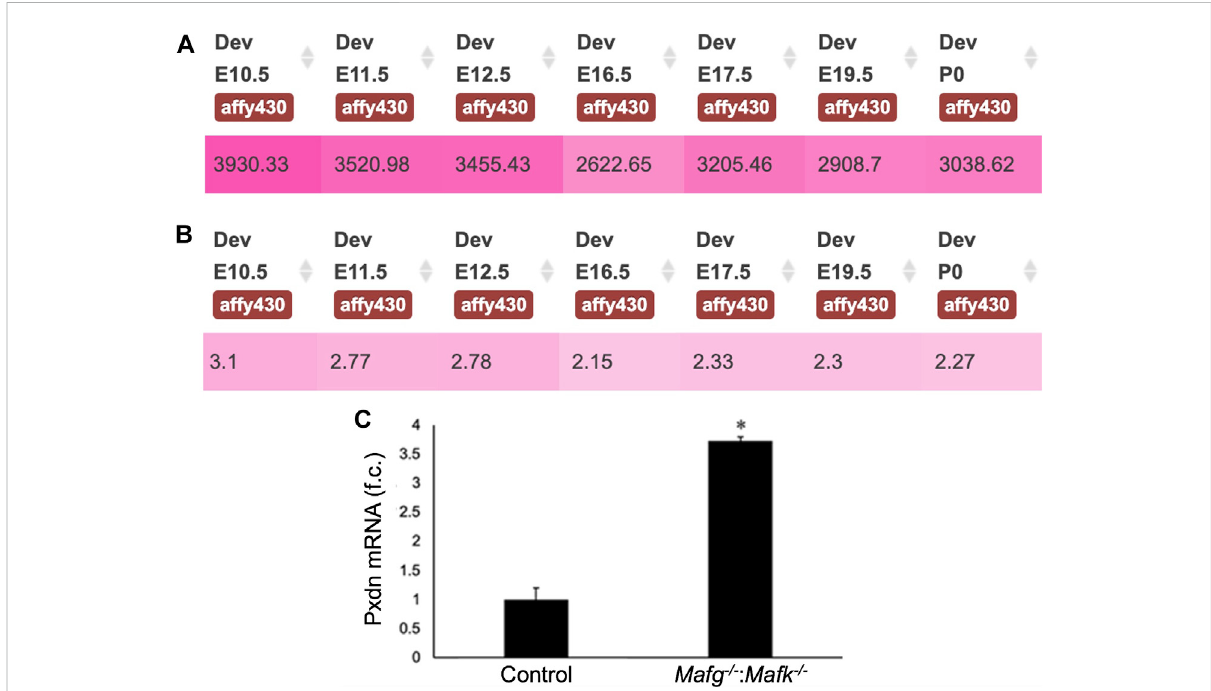
FIGURE 7 Pxdn expression in normal lens development and validation of its abnormally elevated expression in Mafg − / − : Mafk − / − lens. (A) iSyTE analysis shows that the cataract and ocular defects-linked heme-containing peroxidase enzyme, Pxdn, which is identi fi ed by RNA-seq analysis among the DEGs in Mafg − / − : Mafk − / − lenses, exhibits robust absolute expression, and (B) lens-enriched expression, invariousstagesof normalmouseembryonic lens development. (C) RT-qPCR validation of abnormally elevated expression of Pxdn in Mafg − / − : Mafk − / − lenses. Numbers in (A) represent normalized microarrays fl uorescence intensity units as described in Kakrana and coworkers (2018). Fold-change was calculated using the ΔΔ CT- method using Gapdh as a house-keeping gene and statistical signi fi cance was determined using a two-sample Student ’ s t -test. Asterisk indicates p ≤